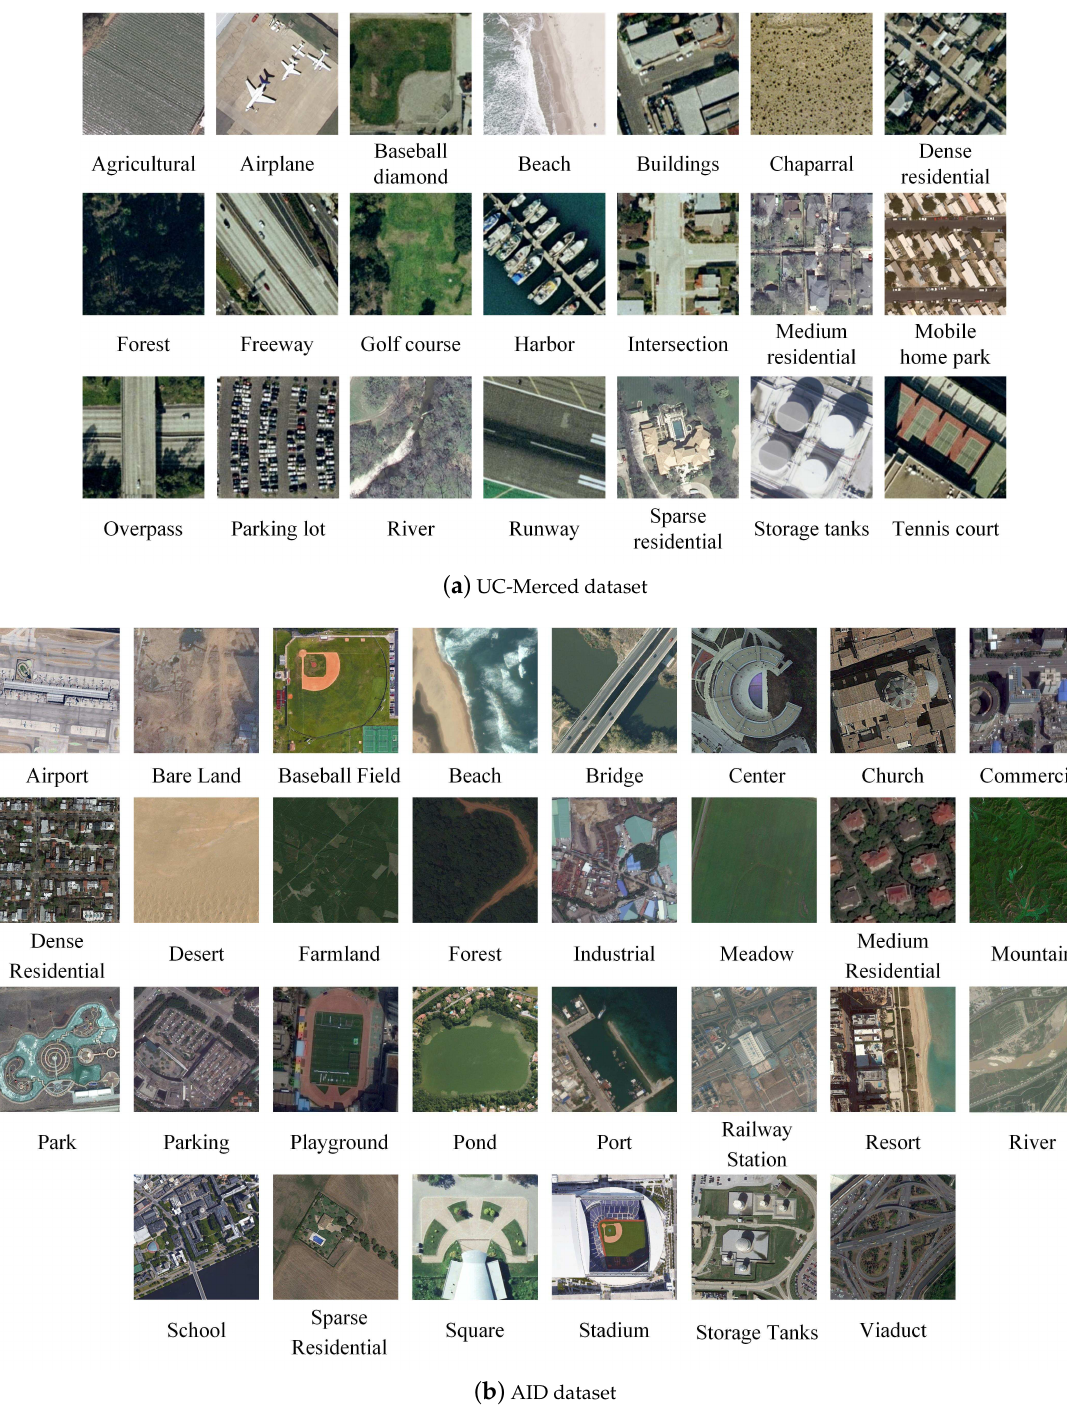
Figure 5. Example images for two remote sensing image